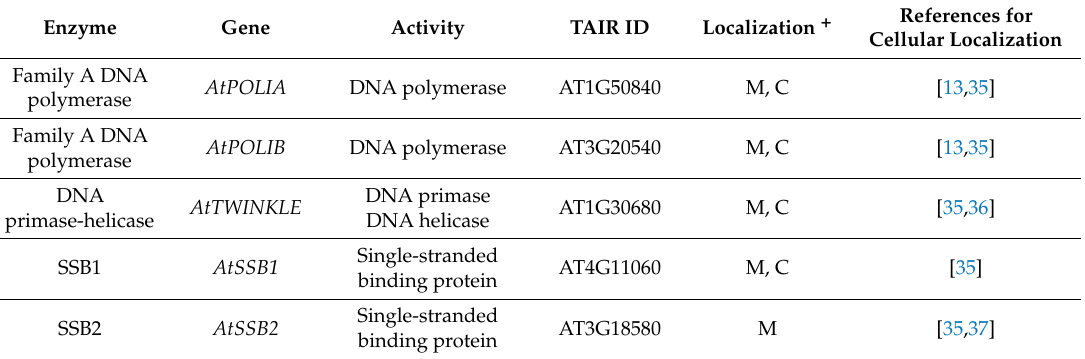
Table 1. Enzymatic components of a minimal organellar replisome.